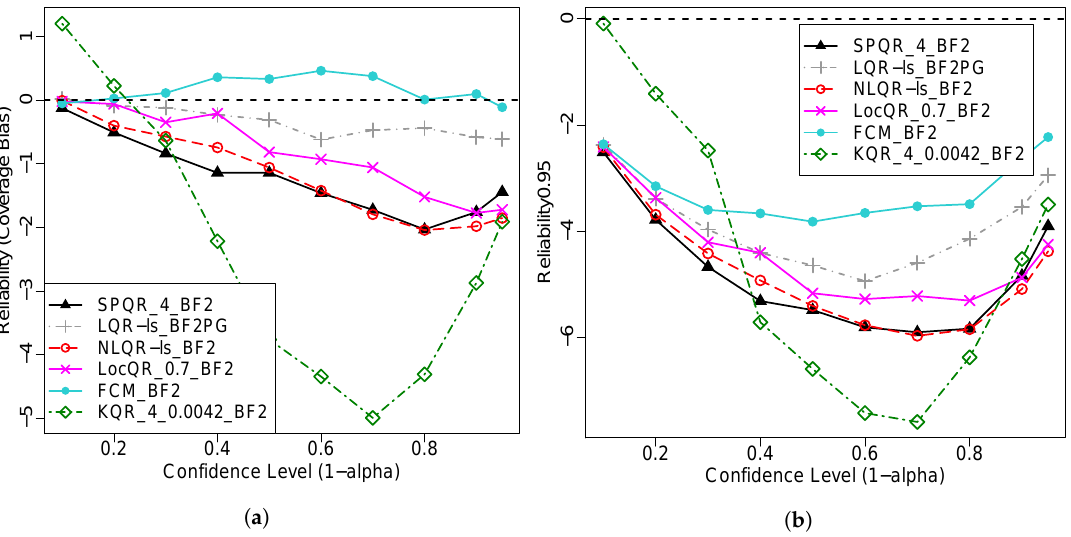
Figure 8. Comparison of Reliability and Reliability 0.95 between various methods over confidence levels. ( a ) Reliability; ( b ) Reliability 0.95 .